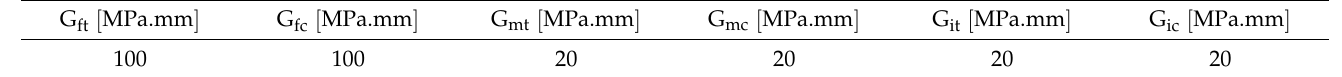
Table 2. Fracture energy for the pultruded GFRP material used in the CT